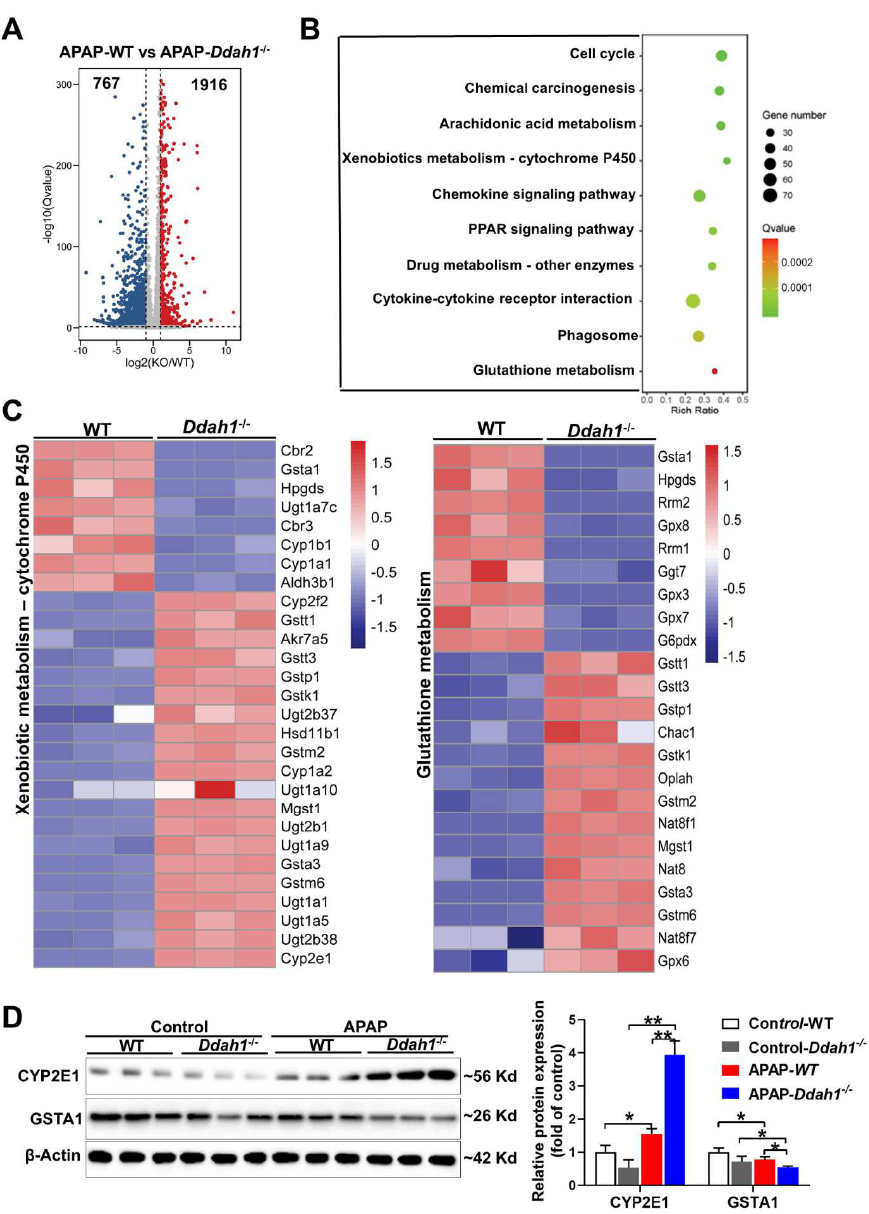
Figure 4. DDAH1 affects the gene expression profile in APAP-treated livers. ( A ) The volcano plot shows the fold changes of differentially expressed genes (DEGs) in the APAP-WT group vs. APAP- Ddah1 -/- group. ( B ) The selected significantly enriched KEGG pathways were listed as advanced bubble charts. ( C ) The gene expression profiles of the DEGs involved in xenobiotic metabolism and glutathione metabolism pathways, as determined by KEGG pathway analysis, are shown in the heat